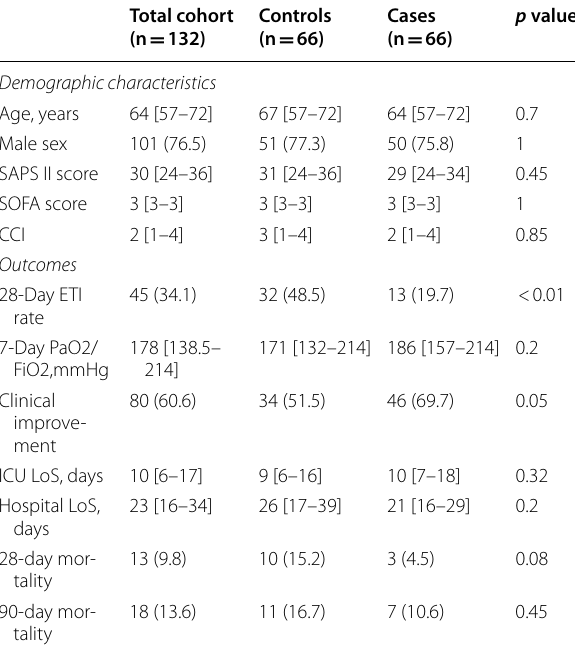
Table 1. Demographic characteristics and outcomes of patients included in the